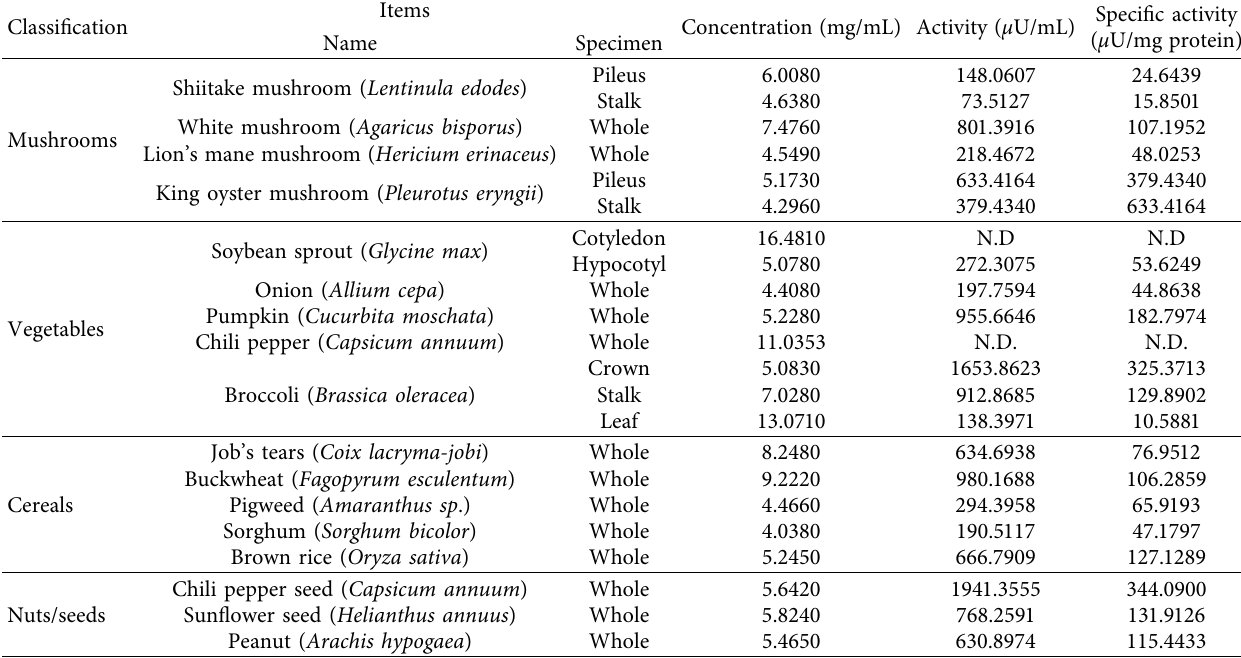
Table 1: Lipase activity in crude protein extracts from domestic agricultural products (spectrophotometric assay). Classification